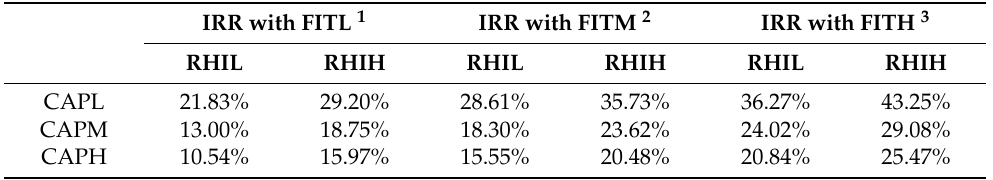
Table 8. Internal rate of return based on three quoted capital expenditure levels, electricity production and 100% heat use (CHP-EH